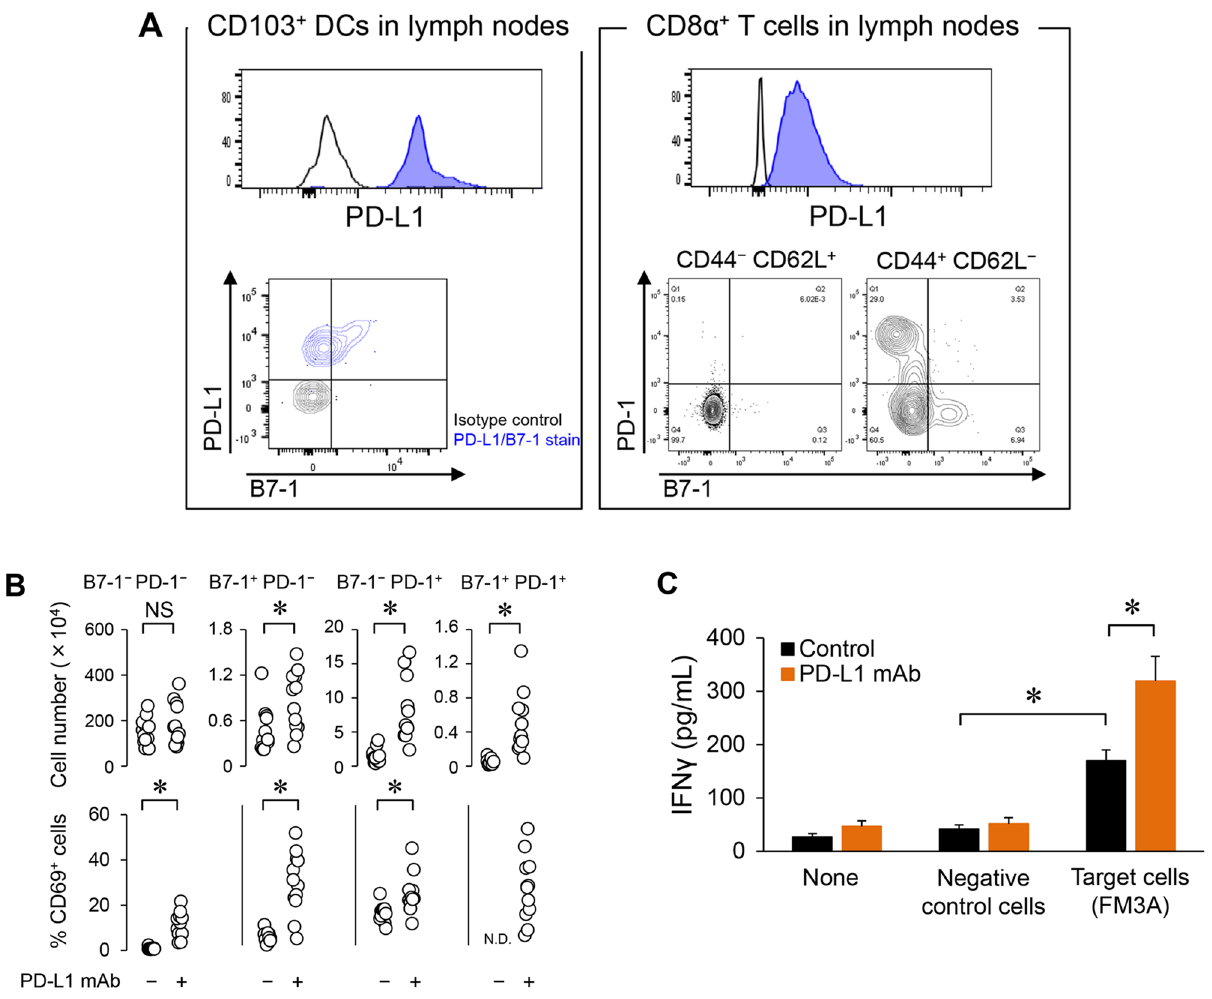
Figure 4. The role of PD-L1 in T cell priming in lymph nodes. ( A ) PD-L1 expression or PD-L1 receptor (PD-1 and B7-1) expression on antigen-presenting dendritic cells (DCs) or CD8α + T cells in tumor-draining lymph nodes at baseline. ( B ) Number of PD-L1 receptor (PD-1 and B7-1) + CD8α + T cells and the frequency of CD69 + cells among PD-L1 receptor + CD8α + T cells in tumor-draining lymph nodes after anti-PD-L1 mAb treatment (Day 4) ( n = 12/group). Statistical analysis used Wilcoxon rank sum test. * P < 0.05; NS not significant. ( C ) Secretion of IFNγ after specific stimulation of lymphocytes in tumor-draining lymph nodes by co-culturing with tumor cells ( n = 3/group). IFNγ was quantified by ELISA. Statistical analysis used Student’s t test and the Holm– Bonferroni method. * P < 0.05. Data are shown as the mean +